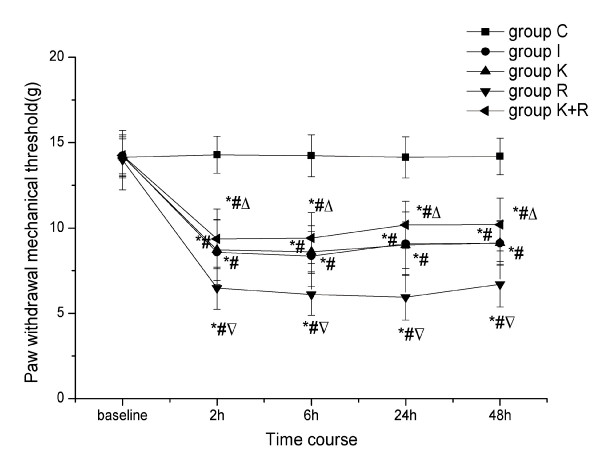
Effects of remifentanil on PWMT during the postoperative period and the intervention of ketamine. Ketamine (10 mg/kg, 0.1 ml) or saline was subcutaneously injected 30 min before surgery. Under sevoflurane anesthesia, remifentanil (0.04 mg/kg, 0.4 ml) or saline was subcutaneously infused in the absence or presence of the right hind paw incision during a period of 30 min. PWMT was evaluated at 24 h before incision and at 2 h, 6 h, 24 h and 48 h after surgery. Number of rats per group was twelve. Data are expressed as means ± SD. *P < 0.01 vs baseline, # P < 0.01 vs group C, ▽P < 0.01 vs group I, △P < 0.01 vs group R.